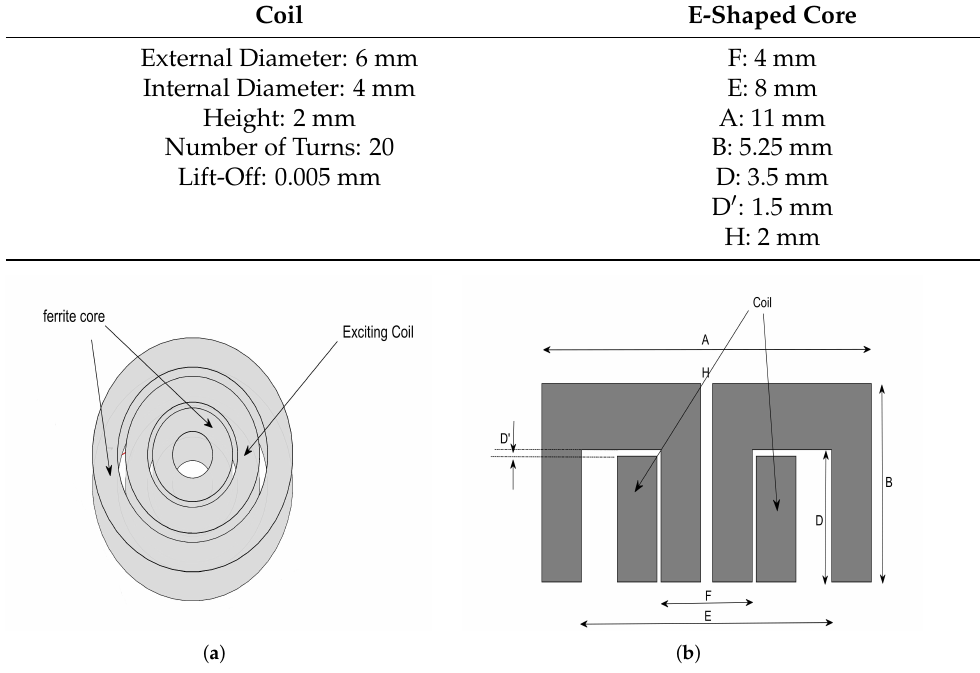
Figure 3. ( a ) Probe configuration and ( b ) a section